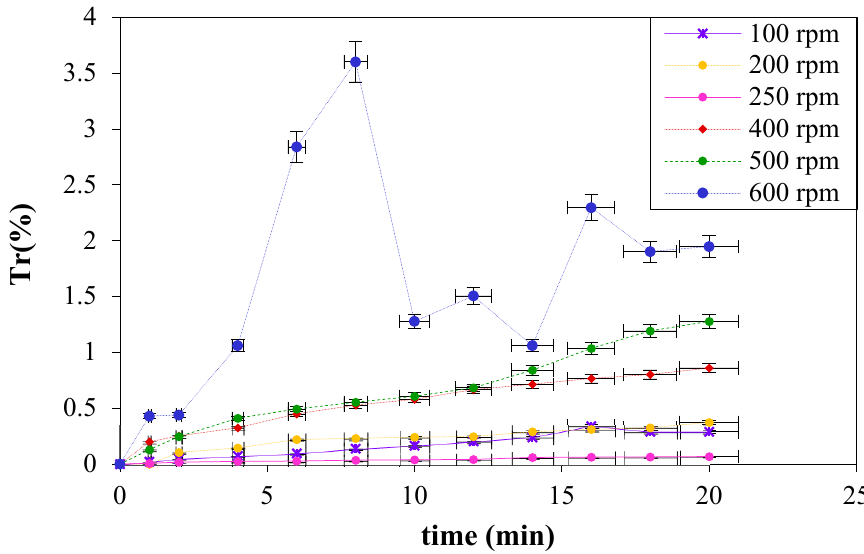
Figure 8. Effect of the stirring speed on the emulsion stability (CSpan 80: 2% wt./wt., w: (100–600)